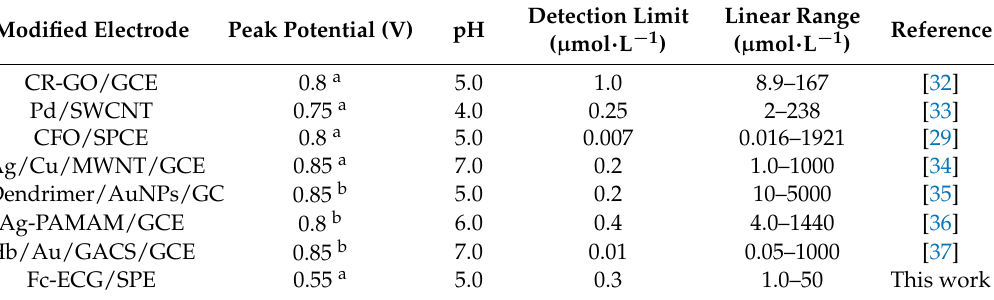
Table 1. Comparison of nitrite detection by different materials modified electrodes with direct electrochemistry. Modified